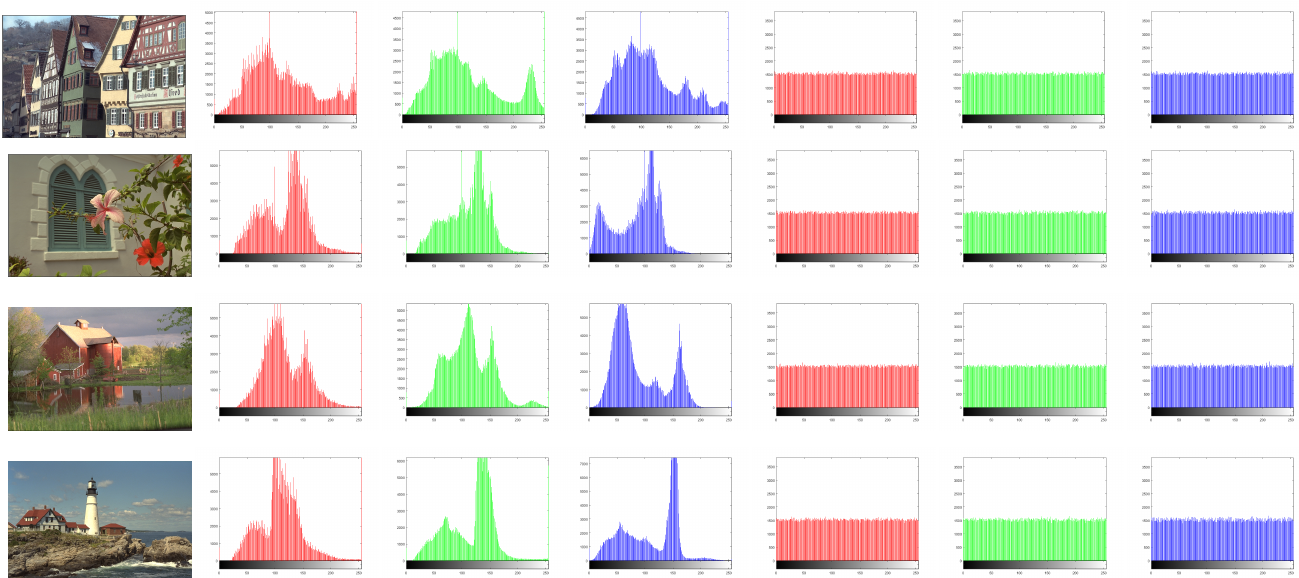
Figure 7. Histograms of the studied images, which the encrypted images (displayed in the last three columns) have a completely identical distribution.